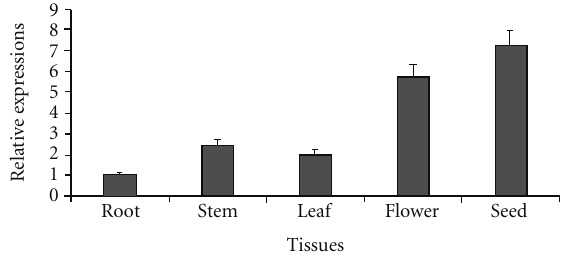
Figure 1: Real-time quantitative PCR analysis expression patterns of Ah FatA in di ff erent tissues of A. hypogaea L. Actin from A. hypogaea L. was used as an internal control. Error bars SD. The transcript level of root was used as the calibrator whose Ah FatA mRNA level was given as 1.